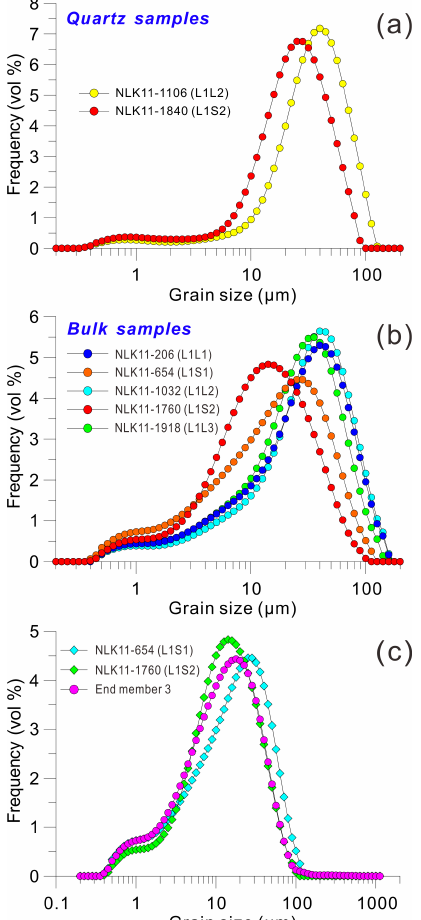
Figure 6. Comparisons of grain size distribution. (a) Between puri- fied quartz subsamples of paleosol and primary loess. (b) Between bulk samples of paleosols and primary loess. (c) Between EM3 and samples from weak paleosol